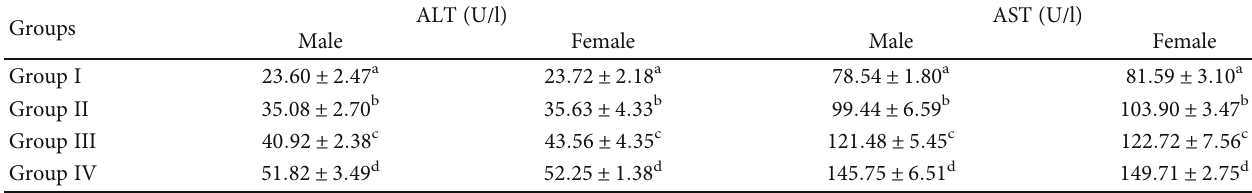
The results were expressed as mean ± SD . Values with di ff erent superscripts within the same column are statistically signi fi cant ( P < 0 : 05